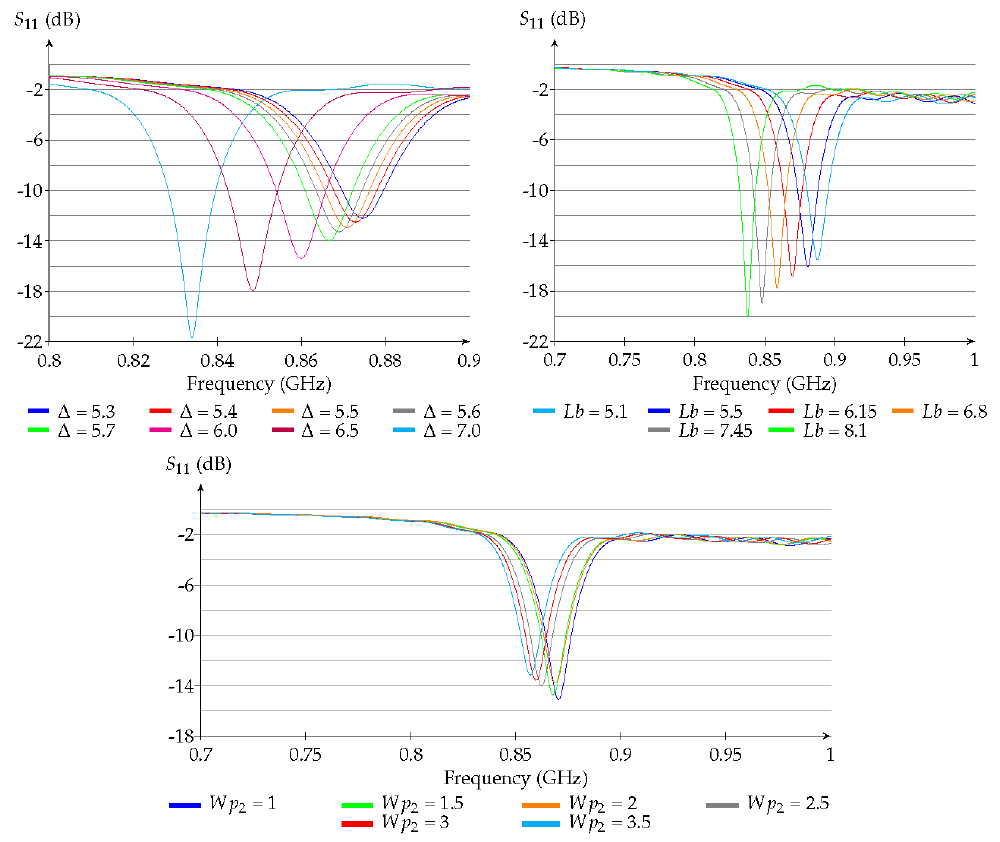
Figure 4. Parametric study of the reflection coefficient S 11 . Top left: changing the ∆ . Top right: changing the branch length ( Lb ). Bottom: changing the branch width ( Wp 2